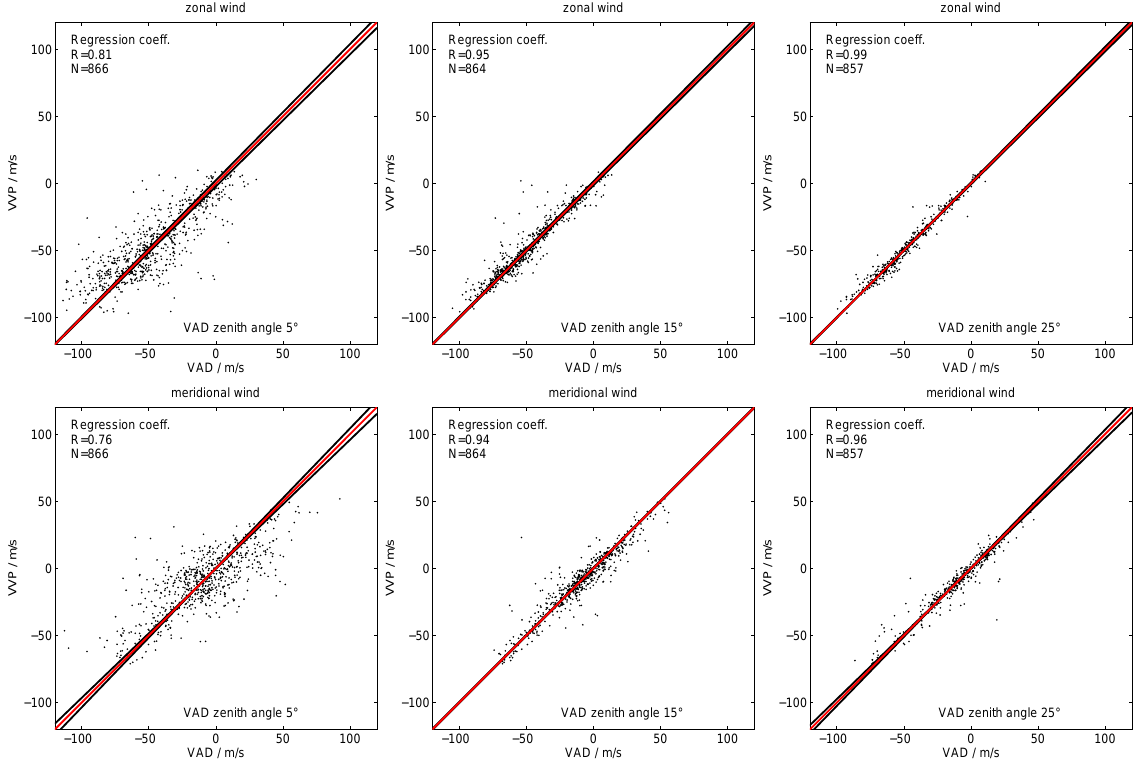
Fig. 7. Scatter plots and correlation coefficients of the zonal and meridional wind determined by a VVP and a VAD analysis including also the available data from 21st of July. The zenith angle of the VAD analysis of each scatter plot is given in the right lower part. The correlation coefficient and the number of data points are given by the capital letters R and N , respectively.